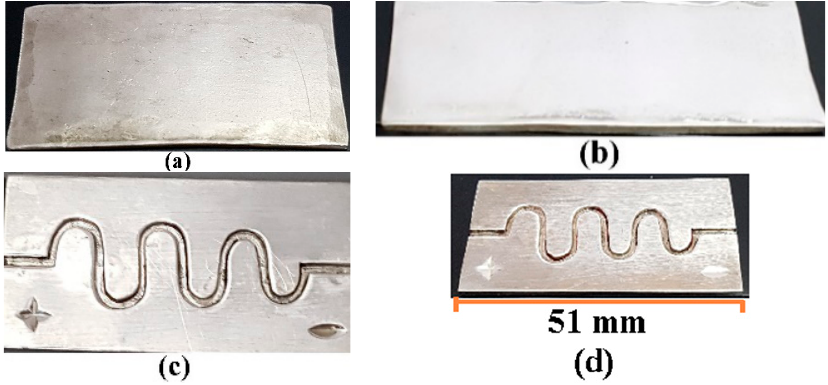
Figure 7. Simple micromachining fabrication of DSMC [2]: ( a ) Raw silver substrate; ( b ) Electro- polishing and ultra-clean surface; ( c ) The real fabrication of the DSMC; and ( d ) Scale of the DSMC.